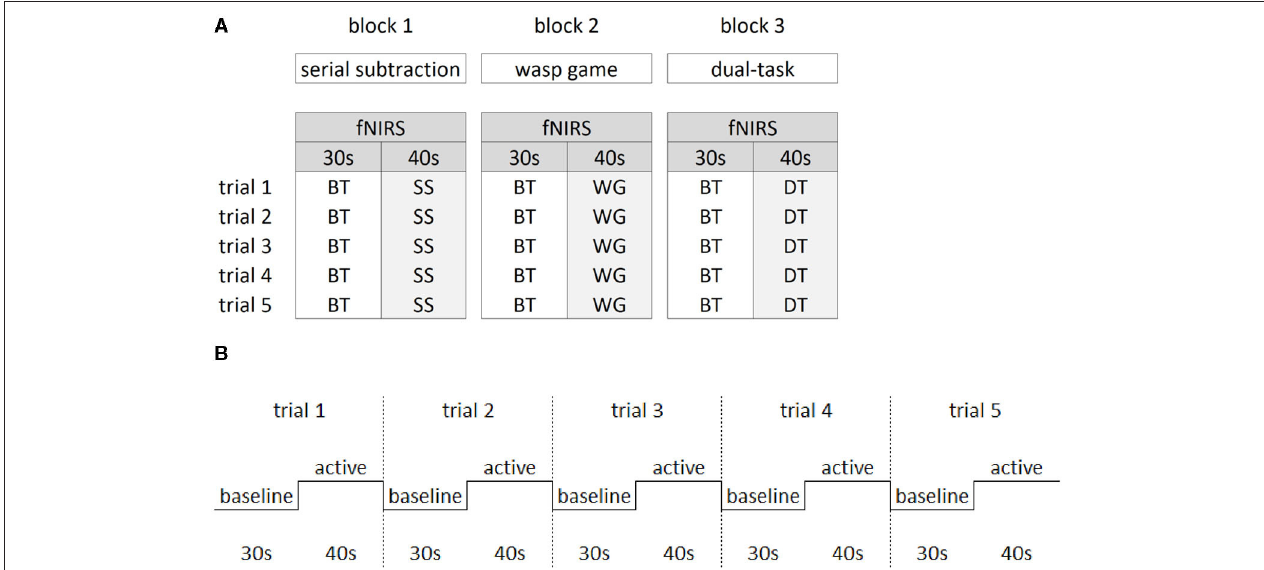
FIGURE 2 | Study design. The block design (A) consisted of three blocks of the main manipulations of interest. Within each block, the baseline task (BT) was alternated with either the serial subtraction task (SS), the wasp game (WG) and both SS and WG combined in the dual-task (DT). Per block, five trials were collected for the active and baseline tasks. The latter consisted of standing while watching the screen with a video of the wasp task only, in which visual input from the wasps flying was similar to the active tasks. The repeated block design over five trials (B) consisted of 30s of baseline task alternated with 40s of active task.